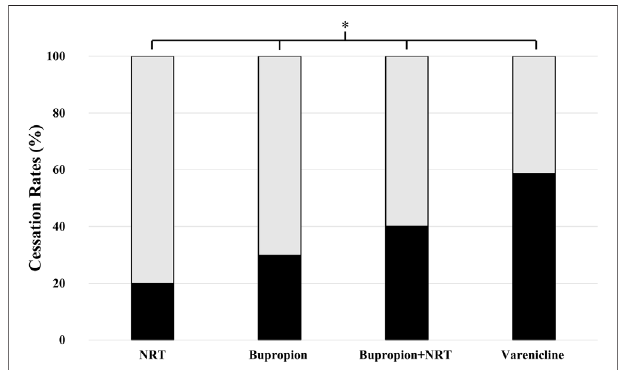
FIGURE 1 | Smoking cessation rates among drug-treatment groups. Cessationrateswereasfollows:20.0%(95%CI=7.6-35.2)forNRTusers( n =40), 29.8% (16.7-47.6) for bupropion users ( n = 47), 40% (15.2-77.9) for bupropion + NRT users ( n = 15) and 58.5% (43.5-88) for varenicline users ( n = 41) (Chi-